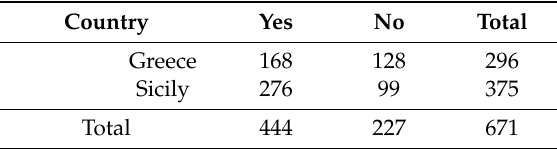
Table 7. Do you receive health